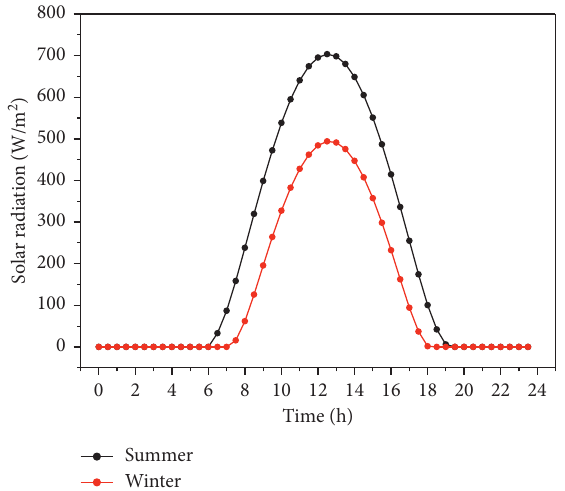
Figure 4: Seasonal variation of solar radiation intensity on the bridge surface.